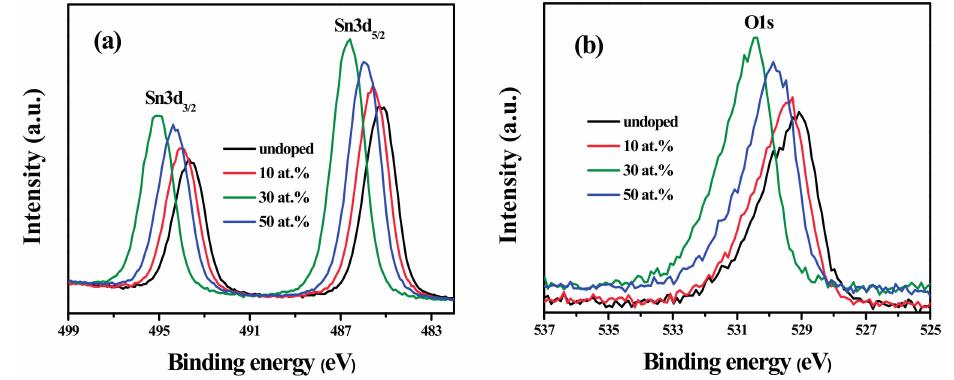
Figure 5. XPS spectra of SnO 2 and FTO NPs: ( a ) Sn3d; ( b )